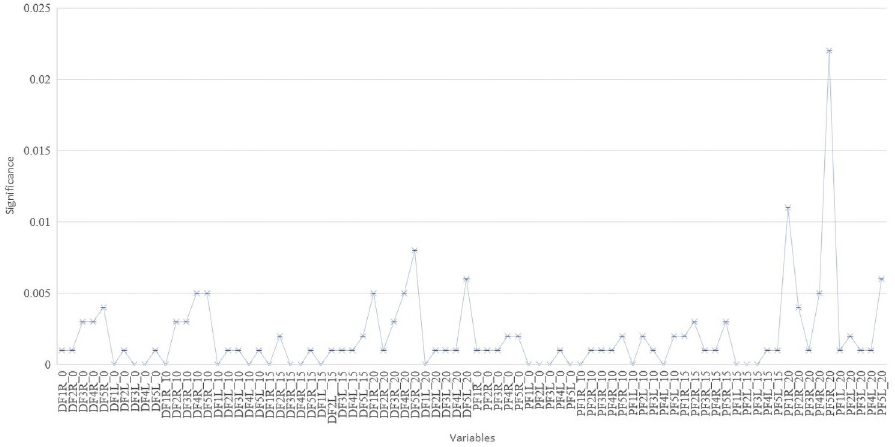
Fig 3. Two-tailed hypothesis test at 95% confidence level for ROIs